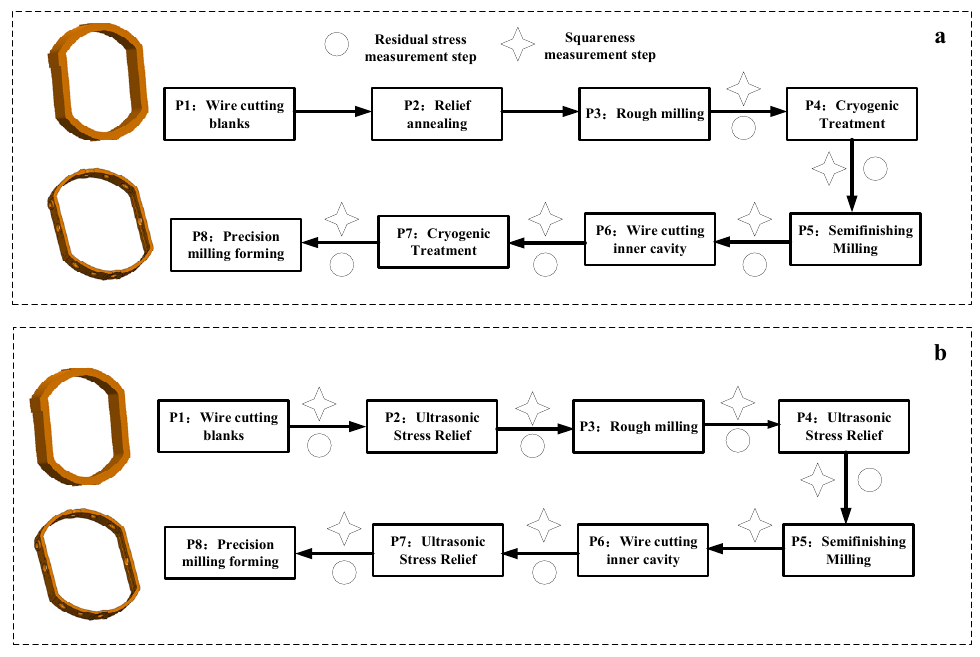
Figure 3. Detection and residual stress elimination process of outer ring components. ( a ) traditional machining process of TC4 thin-wall outer ring; ( b ) ultrasonic machining process of TC4 thin-wall outer ring. Table 1. Description of residual stress